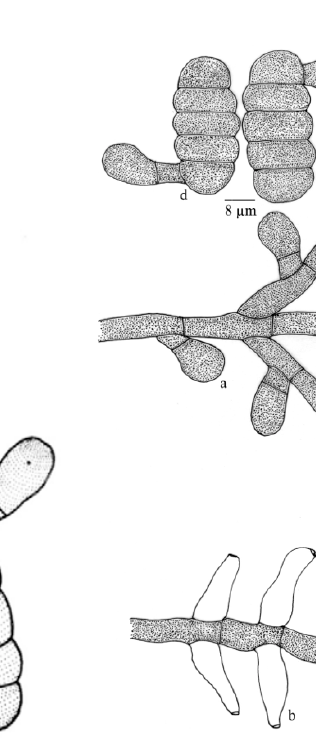
Figure 22. Asteridialla scolopiae a - Appressorium; b - Phialide; d - Ascospores; h - Perithecial wall cells